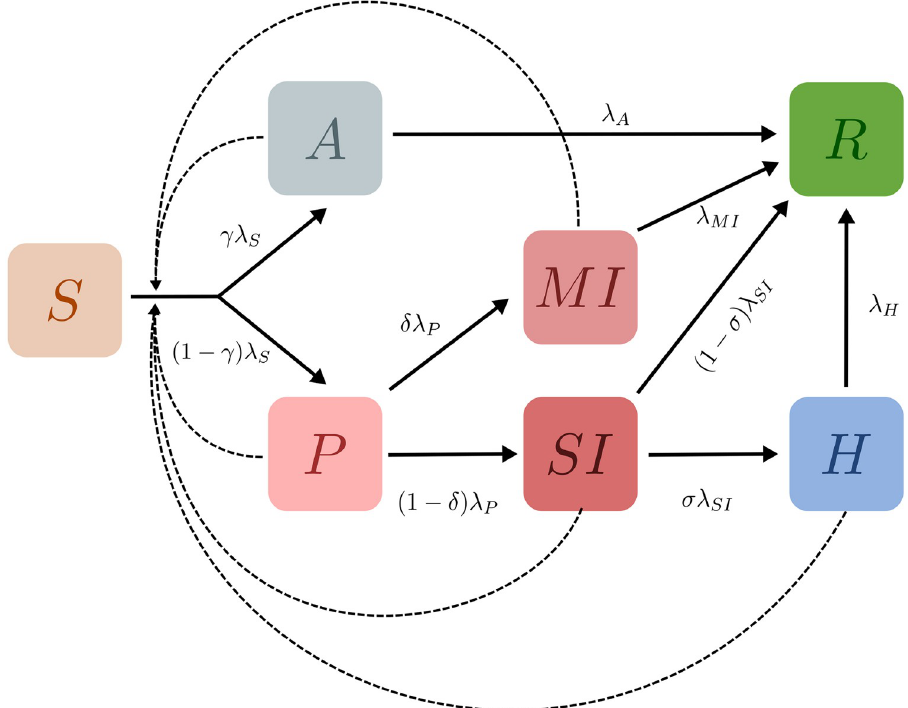
Fig 1. Schematic of the epidemiological model. Boxes show the 7 compartments of the model, i.e., the set of states that characterise each individual in the population. The compartments are (S)usceptible, (A)symptomatic, (P) resymptomatic, Mildly Infected (MI), Severely Infected (SI), (H)ospitalized, and (R)ecovered. Black arrows indicate possible transitions between states. The dotted lines indicate that the rate of infection of Susceptible individuals is an increasing function of the number of infected individuals they are in contact with. Recovered individuals are assumed to be immune to further infection.